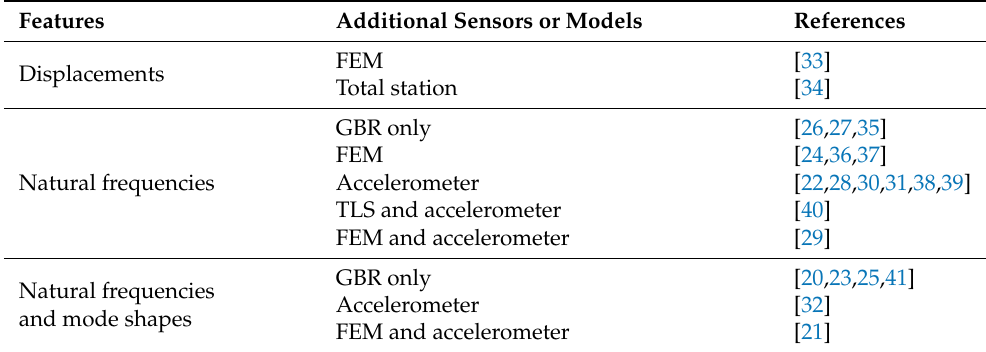
Table 1. Related work for comparison and evaluation of ground-based radar (GBR) in the context of modal analysis. Additional sensors or models for comparison are total stations, terrestrial laser scanners (TLS), accelerometers, or the Finite Element Method